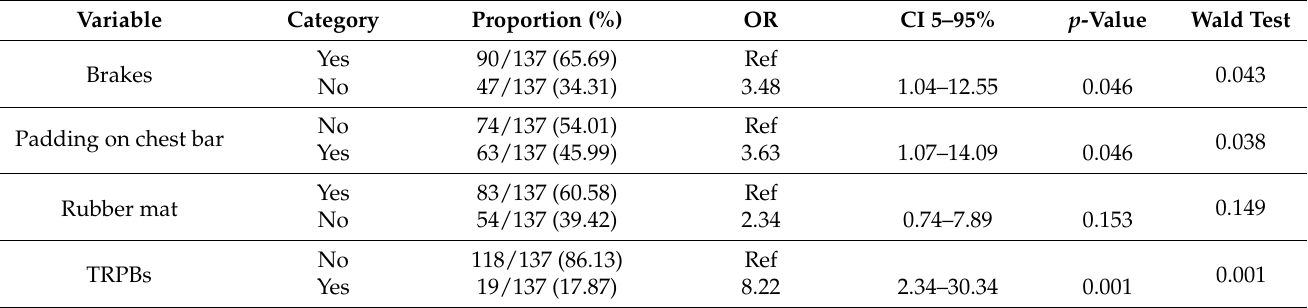
Table 10. Results of the stepwise multivariable logistic regression analysis with variables associated with the occurrence of transport-related horse injuries reported in the replies ( n = 148) to a survey on horse road transport in Italy. Results are expressed as the odds ratio (OR), confidence interval (95% CI), p -value for each predictive variable and total p value of the Wald